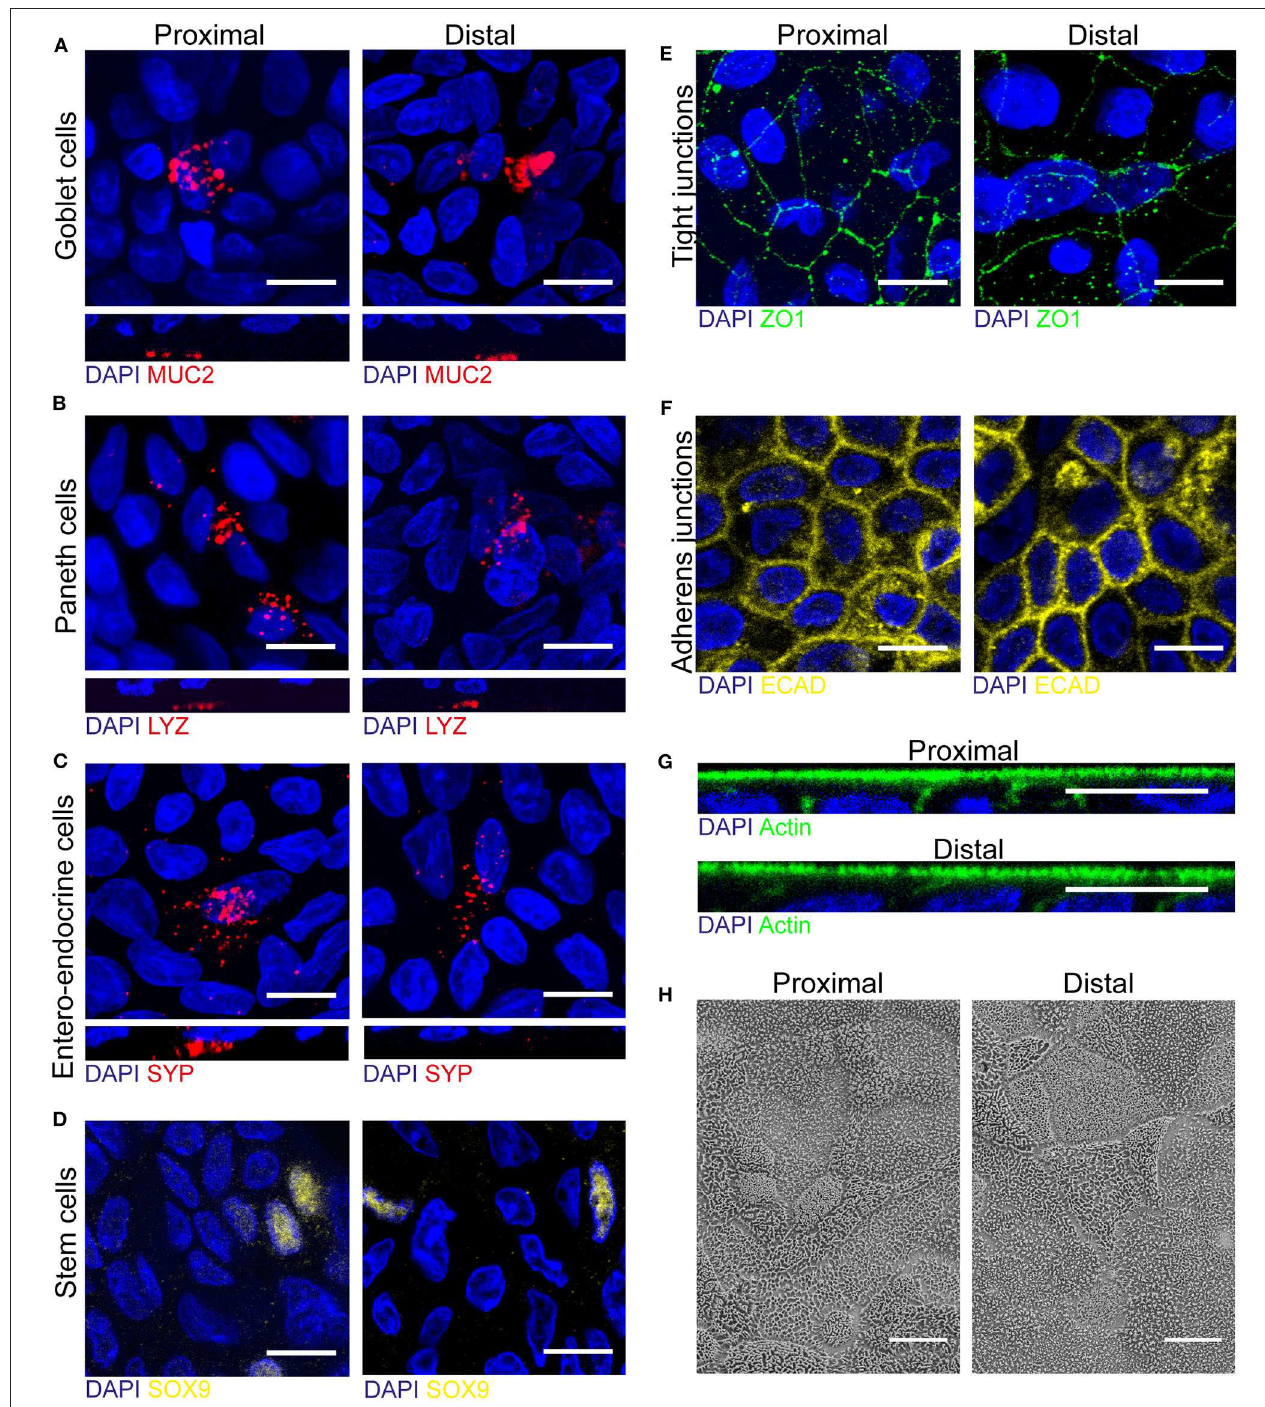
FIGURE 2 | Human fetal organoid monolayer culture is polarized and contains specialized cell types and junctional complexes. (A–D) Proximal and distal small intestinal epithelial monolayers were stained by immunofluorescence on day 14 of culture to identify goblet cells (MUC2, red), Paneth cells (LYZ, red), enteroendocrine cells (SYP, red) and stem cells (SOX9, yellow). (E–G) Immunofluorescence staining to identify tight-junctions (ZO1, green), adherens junctions (ECAD, yellow) and actin (green) in both proximal and distal cultures. (H) Scanning electron microscopy (SEM) of apical surface of proximal and distal small intestinal epithelial monolayers. White scale bar equals 10 µ